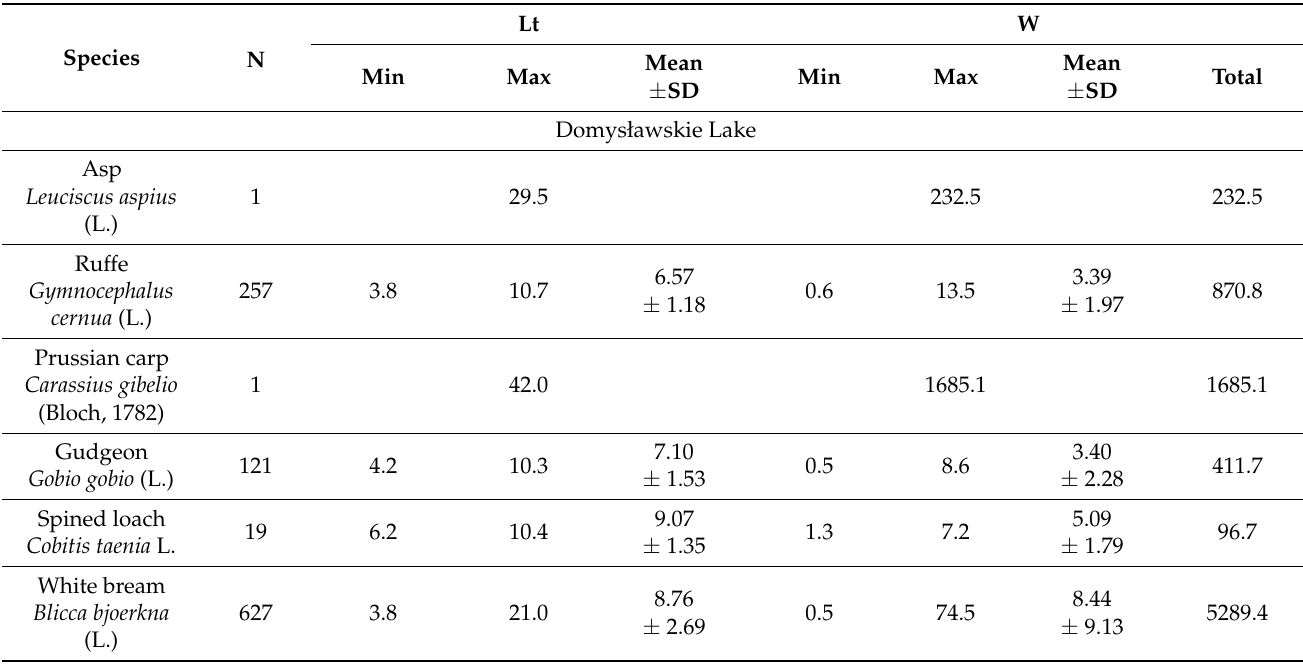
Table 2. Species composition, abundance (N), total length (lt, in cm), and weight (W, in g) of the fish caught.